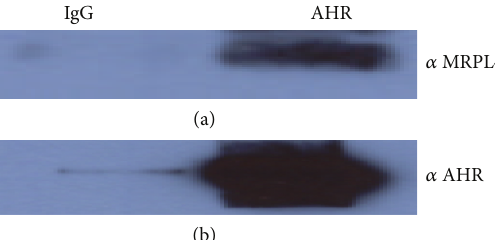
Figure 6: Independent protein interaction verification. Coimmunoprecipitations (Co-IP) using anti-AHR or normal rabbit IgG as negative control were performed in wild type Hepa1c1c7 cells. (a) Western blot probed with anti-MRPL40 (Invitrogen). (b) Positive control, western blot probed with anti-AHR. MRPL40 and AHR control all show marked enrichment in the AHR pulldown lanes over the IgG control